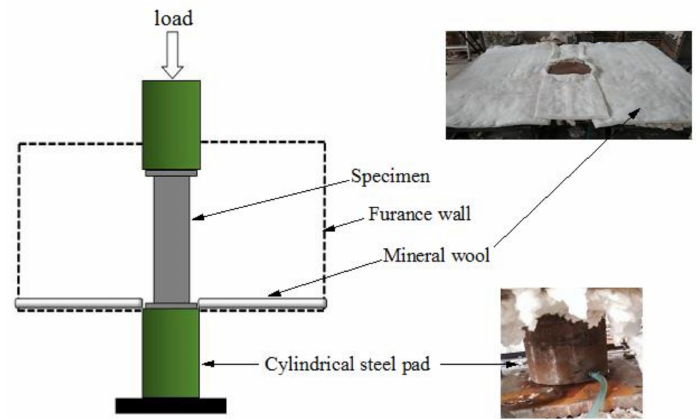
Figure 2. Schematic of the loading device.